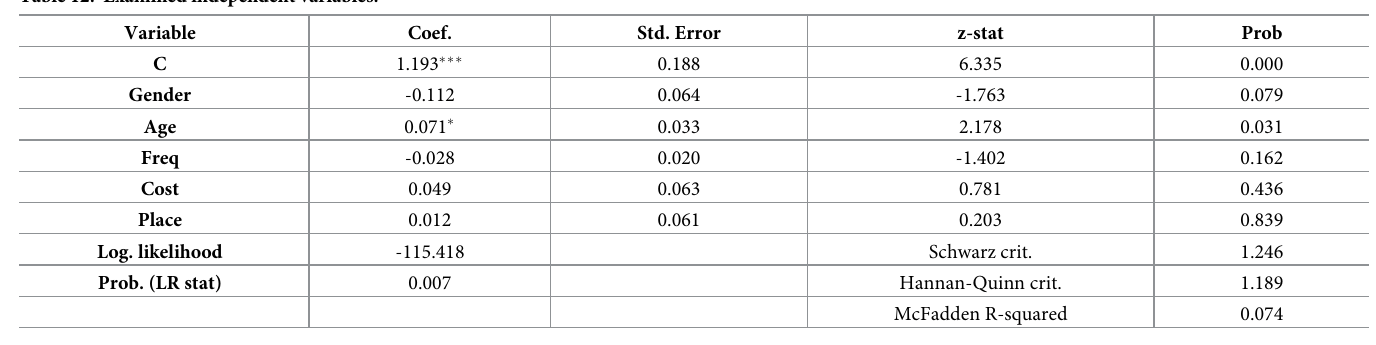
Table 12. Examined independent